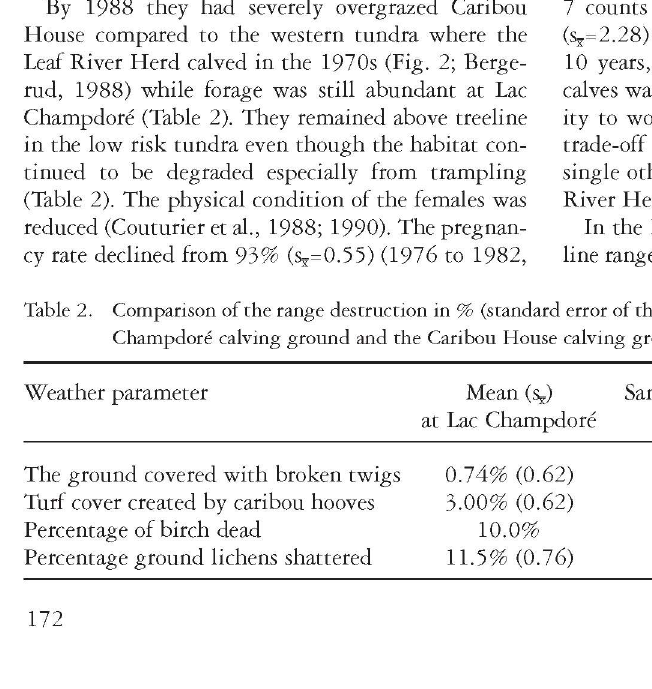
Fig. 2. Grazing and trampling on the Québec-Labrador Peninsula.